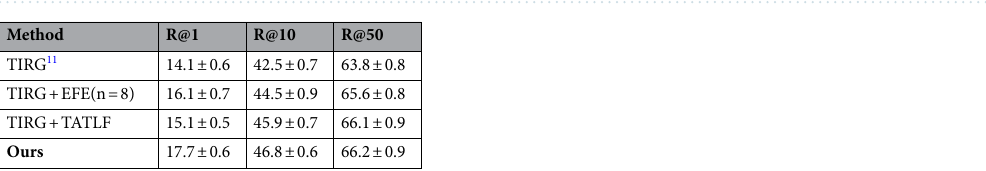
Figure 6. Qualitative Results (R@5): Retrieval examples from MIT-States Dataset. (Created by ‘Microsoft Office Visio 2013’ https:// www. micro soft. com/ zh- cn/ micro soft- 365/ previ ous- versi ons/ micro soft- vision- 2013).